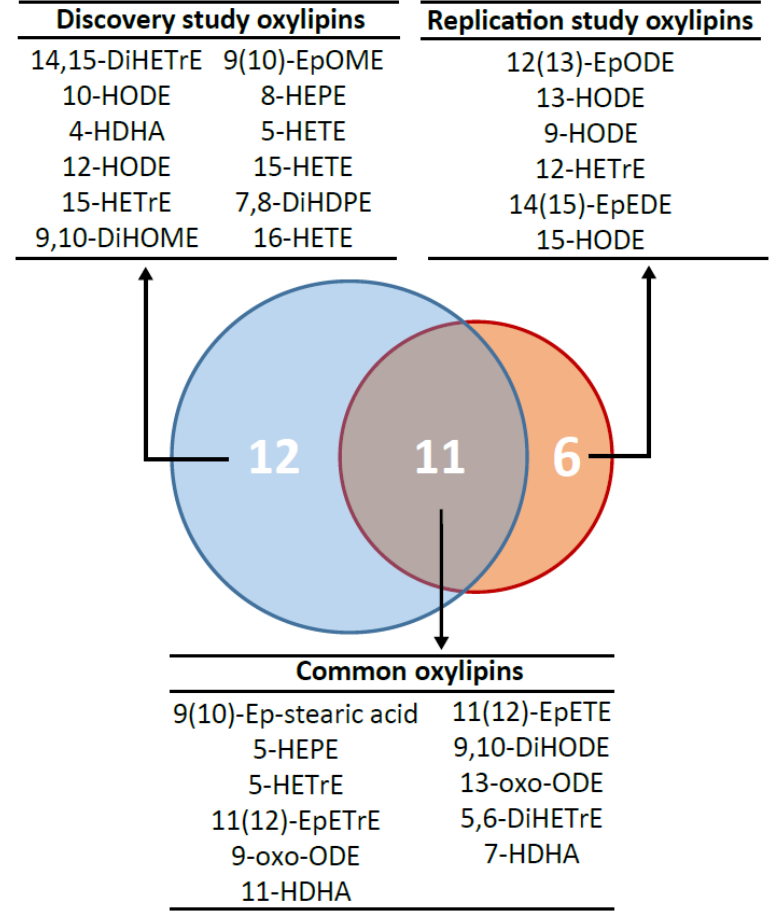
Figure 2. Consistency of the oxylipin signature discriminating MetS participants independently selected in the Discovery and the Replication studies. Venn diagram showing the common and specific oxylipins selected in the Discovery and Replication studies.